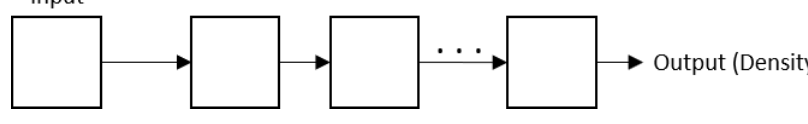
Figure 6. General structure of the single-column